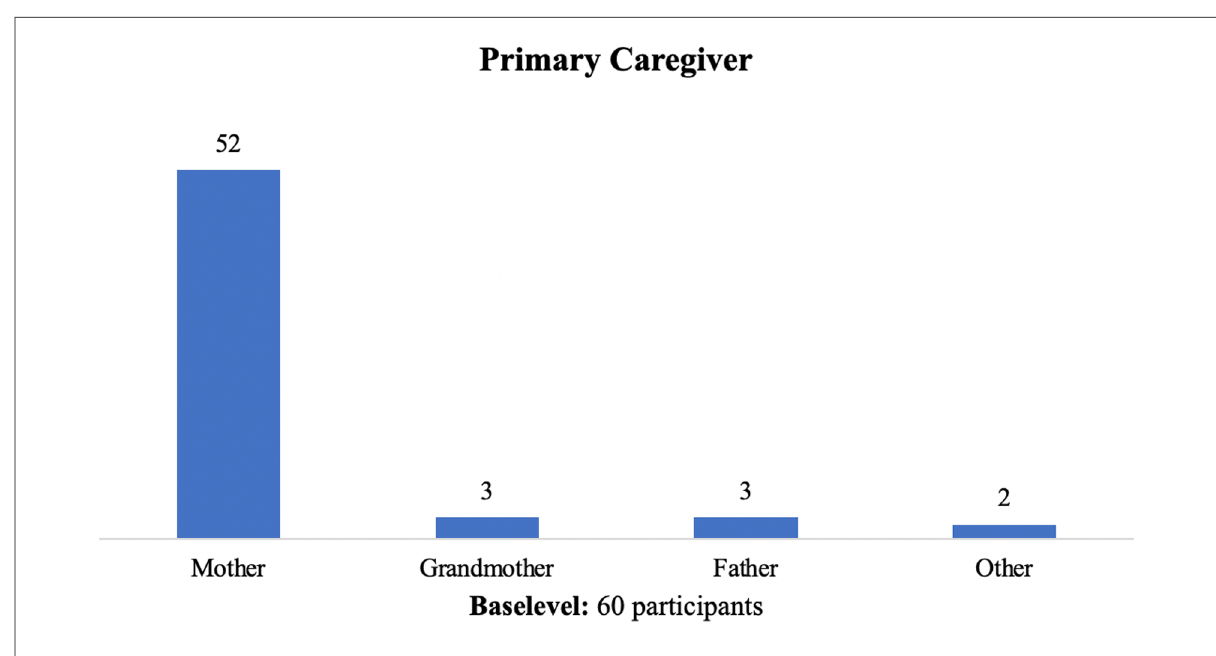
FIGURE 3 Who is the primary caregiver of children with